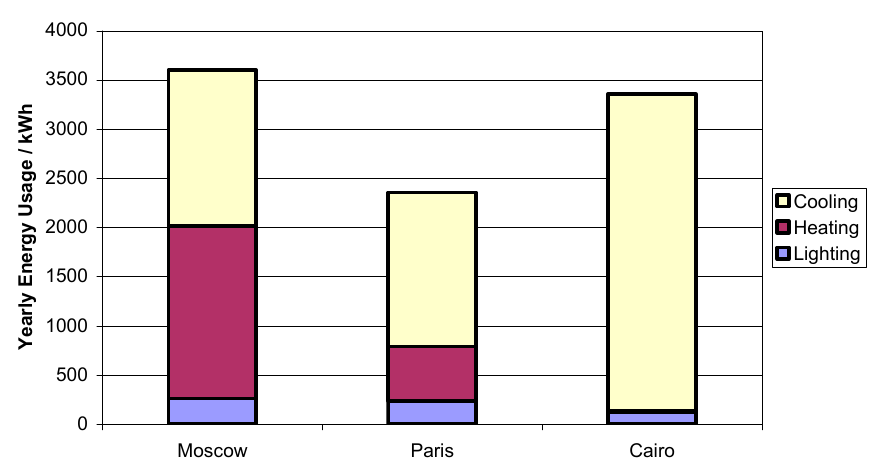
Figure 1. Total energy requirements for each environment due to the absorbing properties of the idealized spectra running only as cold spectra. Colors correspond to the individual energy requirements; yellow is cooling; maroon is heating; blue is lighting.